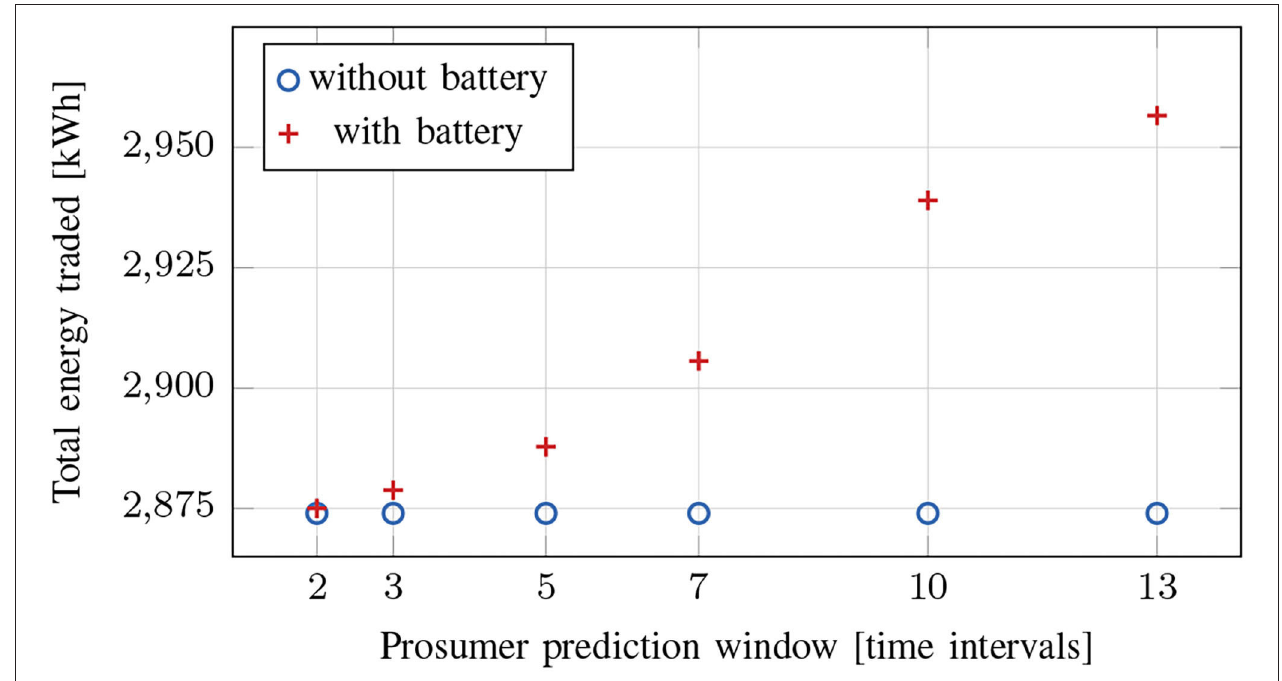
FIGURE 9 | Total amount of energy traded in the entire microgrid (with and without batteries) for various prediction window lengths.